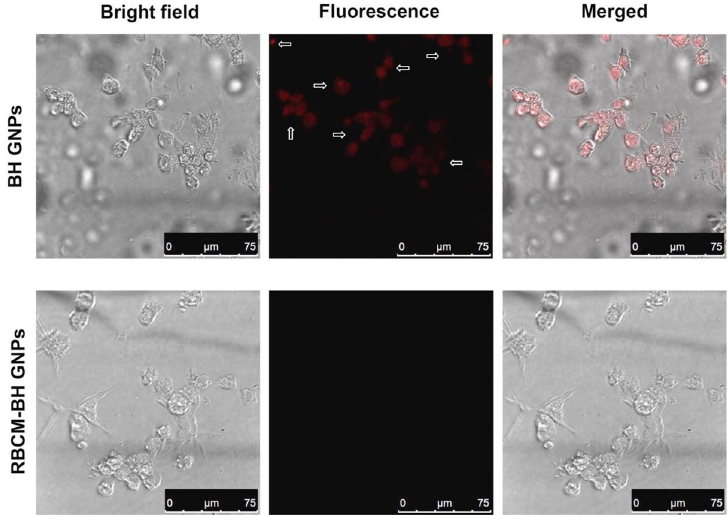
Figure 6. Fluorescence images of RAW 264.7 macrophage cells treated by RBGPs and BGPs, respectively. The GNPs were labeled with Cy5 (red).